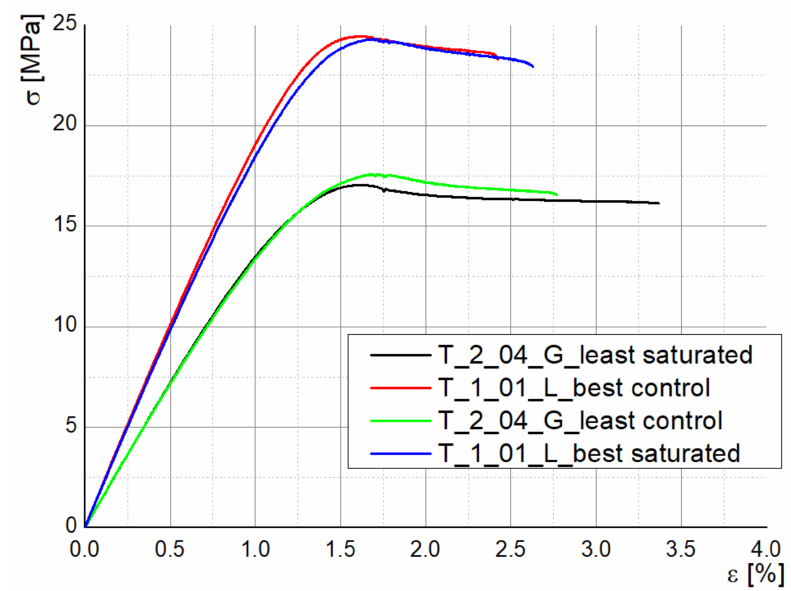
Figure 8. Stress–strain curves for saturated and control tensile